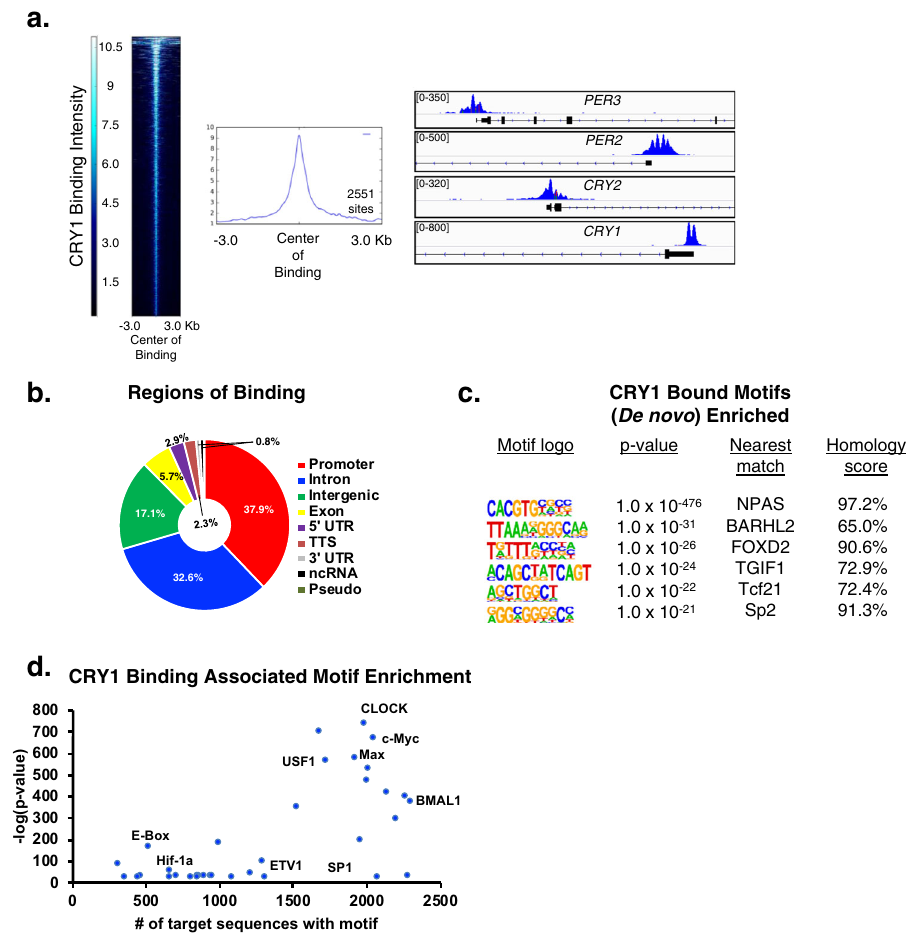
Fig. 2 CRY1 cistrome mapping reveals interplay with oncogenic transcription factors. a Heatmap and pro fi le plots showing number and intensity of binding sites. Right — Genomic traces of CRY1 binding at core circadian clock genes. b Genomic distribution analysis representing genomic binding regions. Percent of total binding is shown in indicated regions. c De novo motif enrichment of CRY1 binding in vehicle treated C4-2 cells within 50 bp binding window on each side of the center of binding with the cutoff of p < 10 − 20 . d Known motif enrichments of CRY1 binding in vehicle treated C4-2 cells within 500 bp binding window on each side of the center of binding with the cutoff of p < 10 − 20